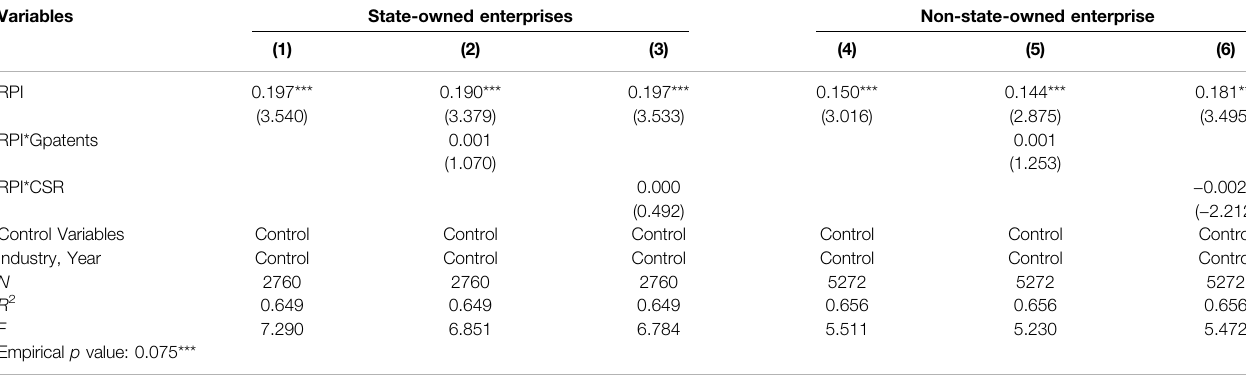
TABLE 11 | Sample regression results of different property